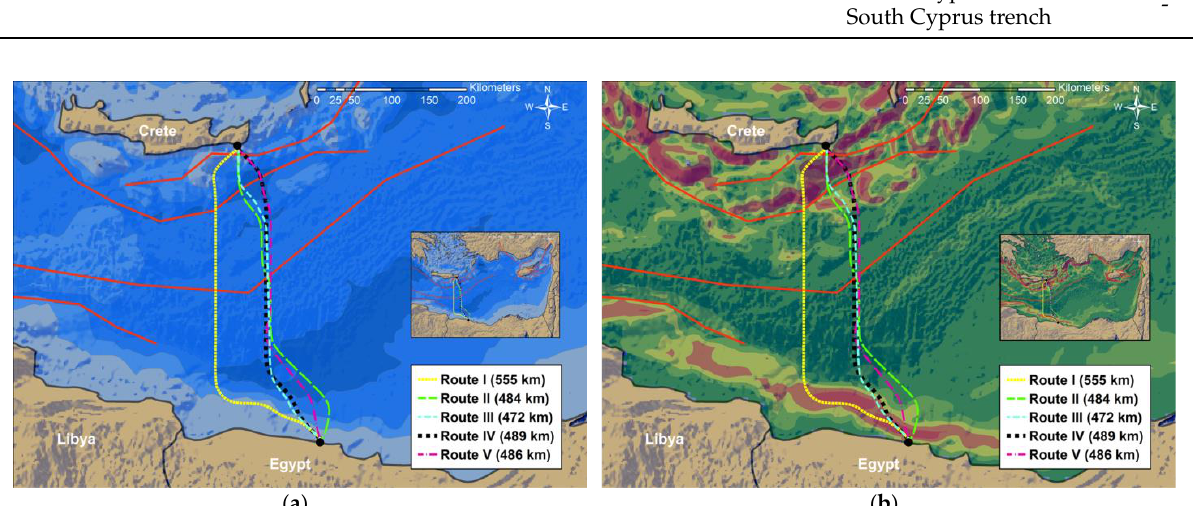
Table 4. Weight-influence and rating score of each of the adopted criteria and sub-criteria for case Figure 12. ( a ) Maximum axial strains of the submarine telecommunication cable for different net study 2. bedrock displacements, and ( b ) actual displacement of the cable at the fault rupture zone.